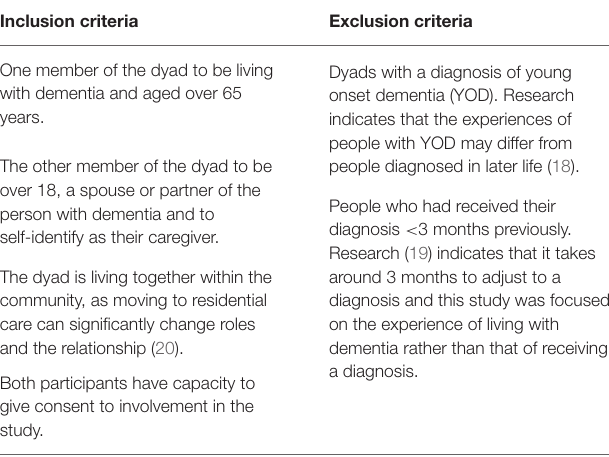
TABLE 1 | Participant inclusion and exclusion